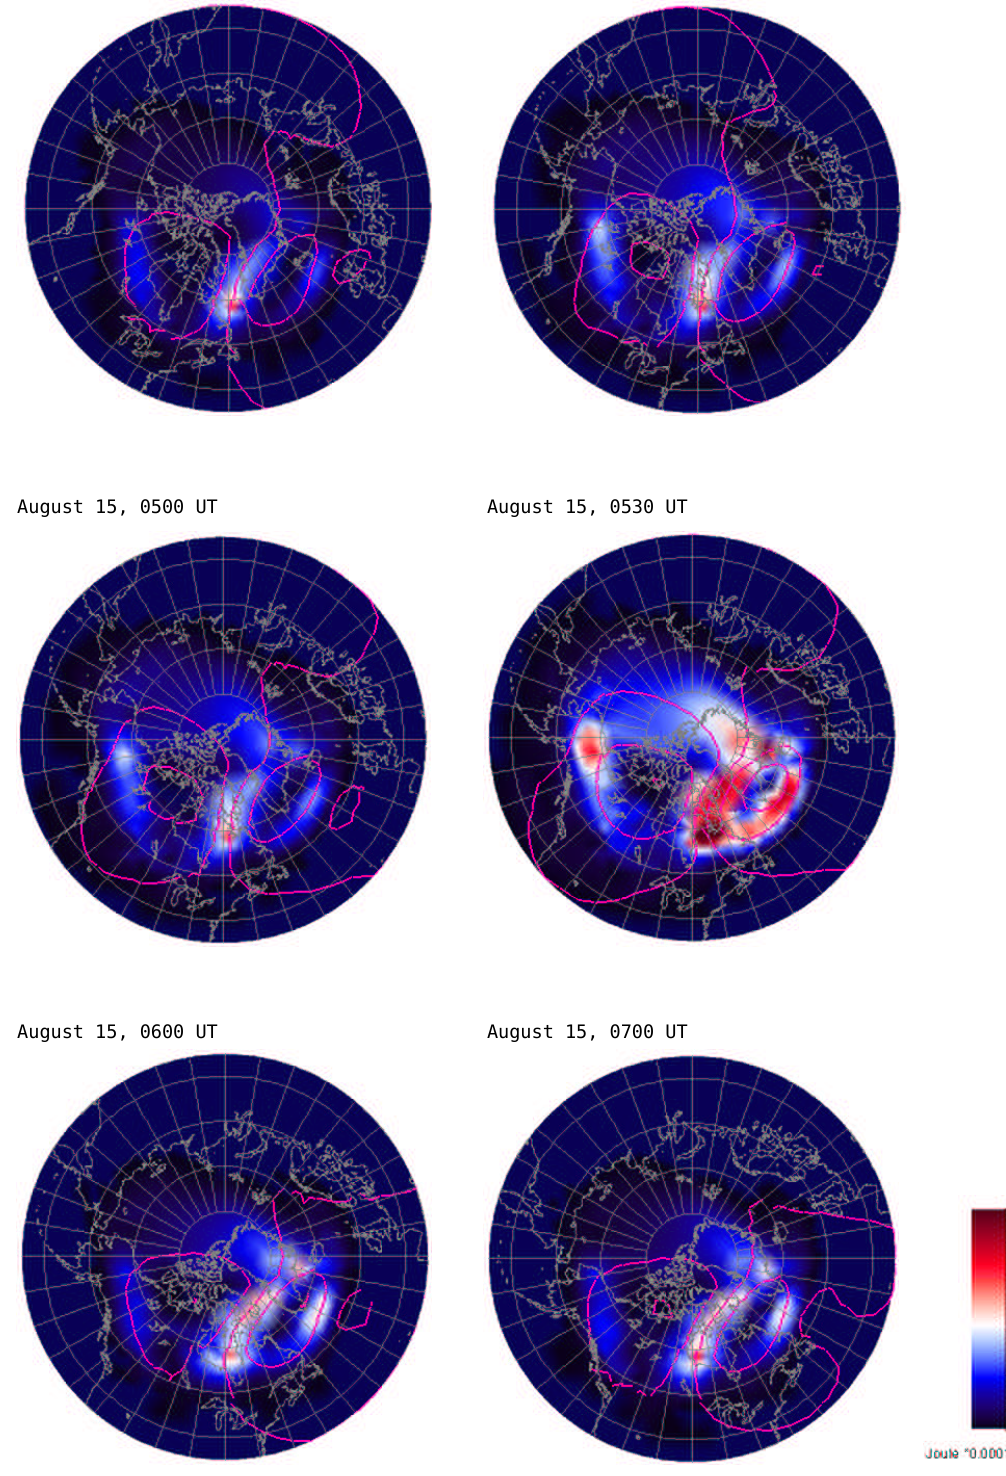
Fig. 7. Joule heating power color-coded in the simulation at six moments of time during the August 2001 substorm, units Wm − 2